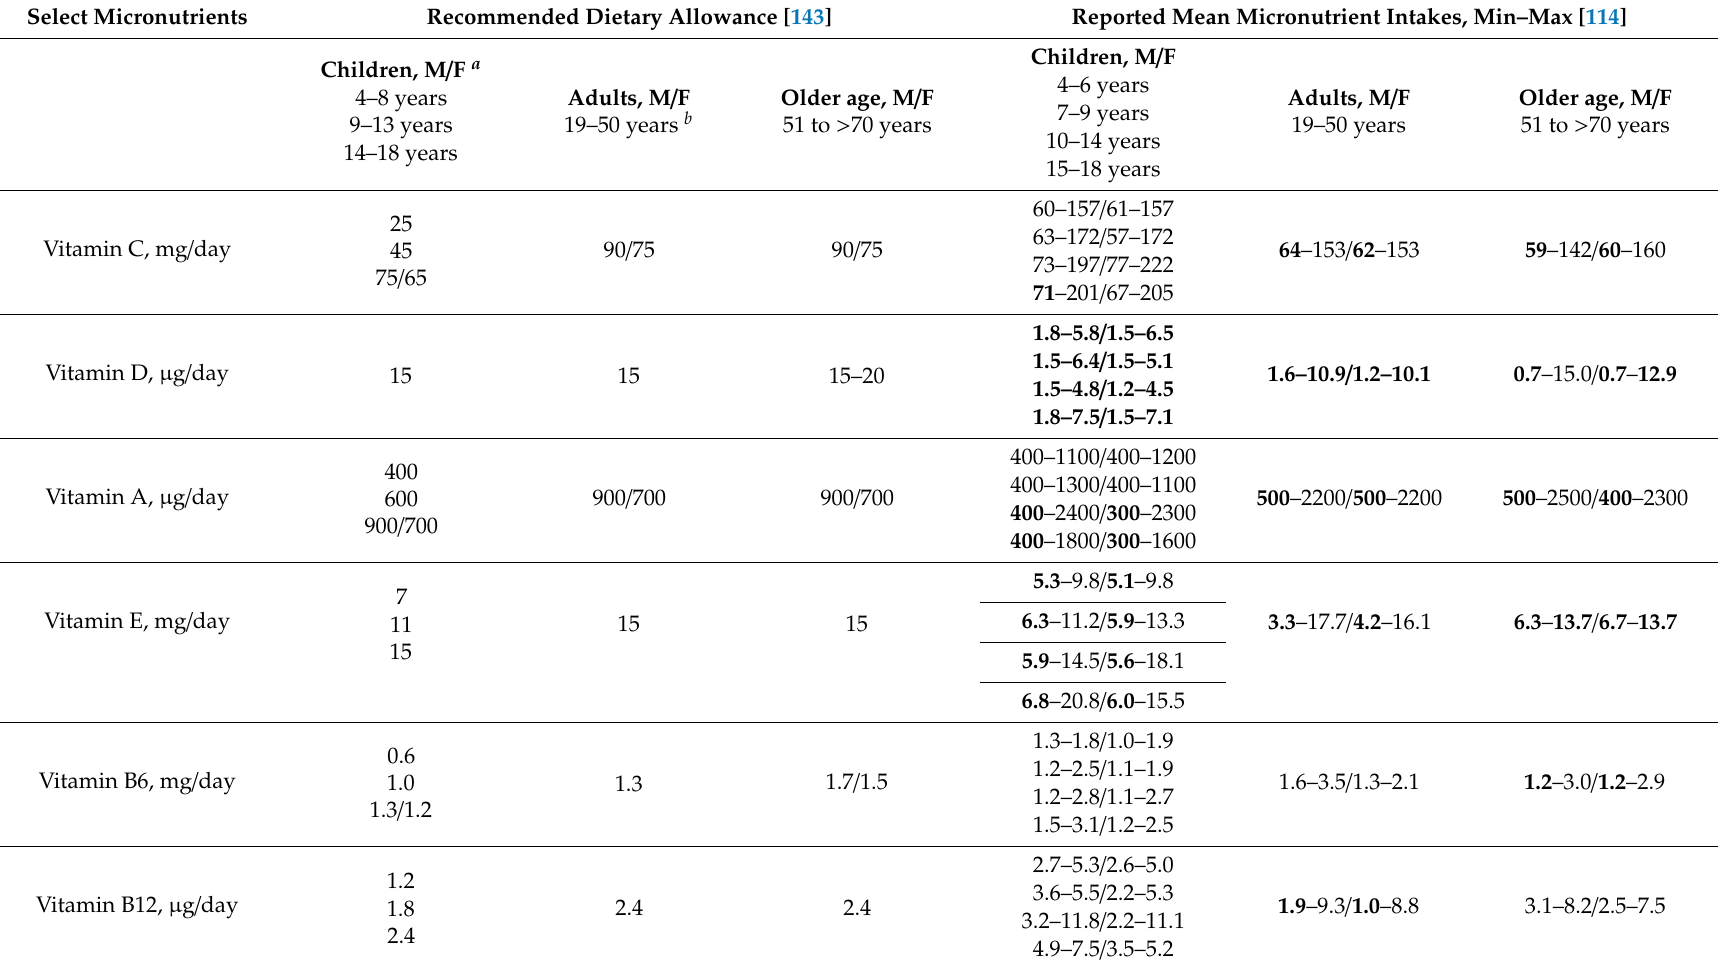
Table 3. Life-stage-specific micronutrient deficiencies in